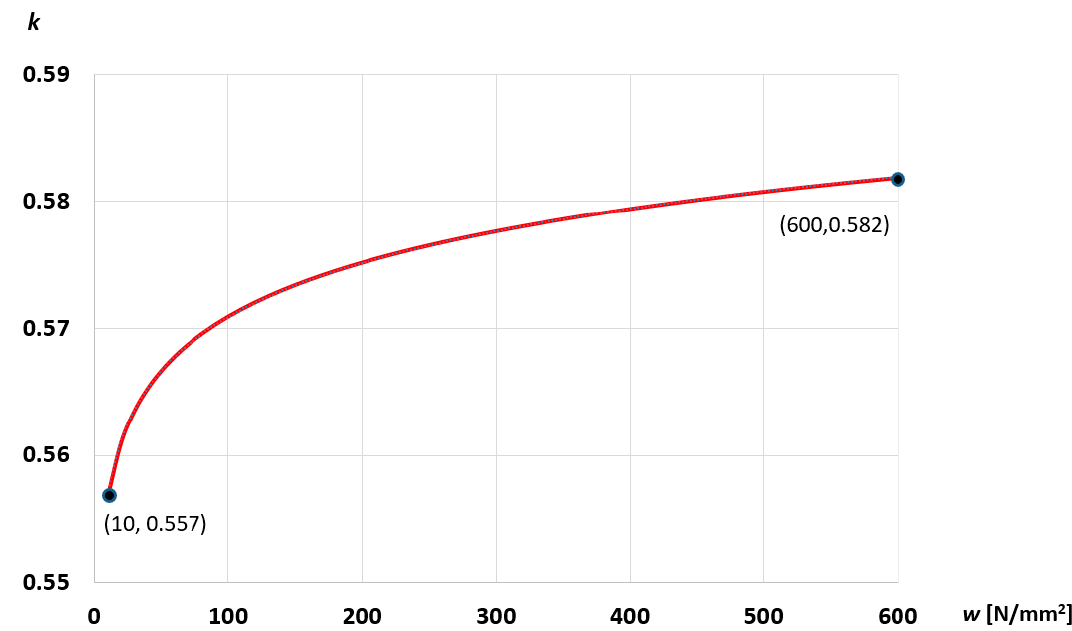
Figure 9. Dependence of k ‐ value on the plastic work.